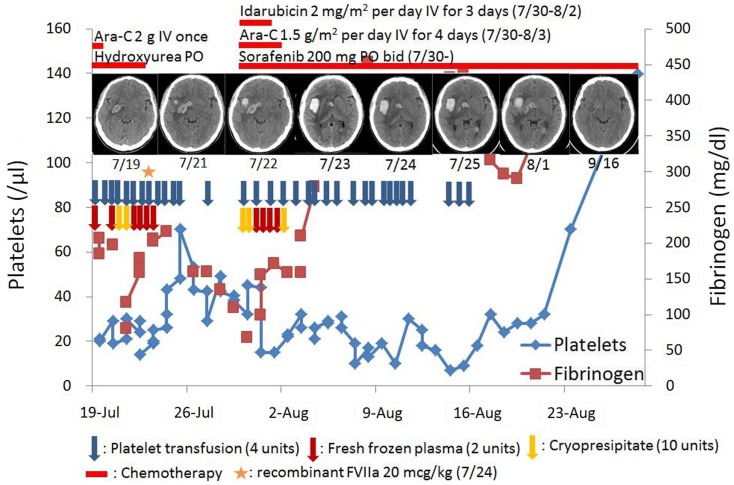
Clinical course.